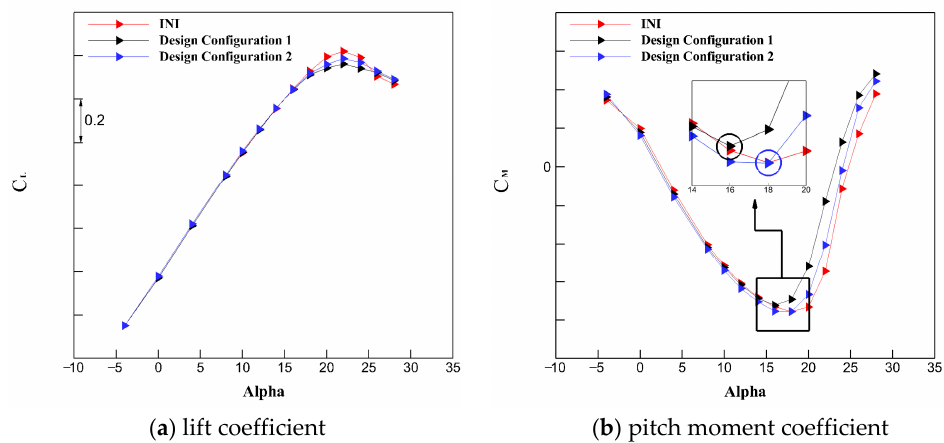
Figure 25. Aerodynamic coefficients of INI, Design Configuration 1 and Design Configuration 2.